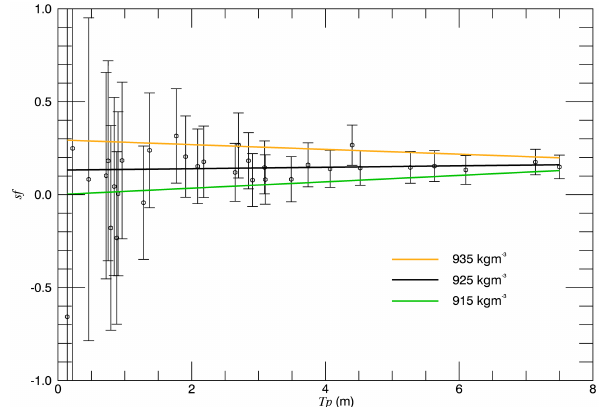
Figure 4. Solid fraction (sf) derived by Eq. (1) (black circles) and expected errors from Eq. (2) derived for 32 measurement sites. A linear fit is shown in black for this data set. The influence of varying sea ice density ( ρ i ) is also displayed as linear fits for higher and lower ρ i values (no symbols